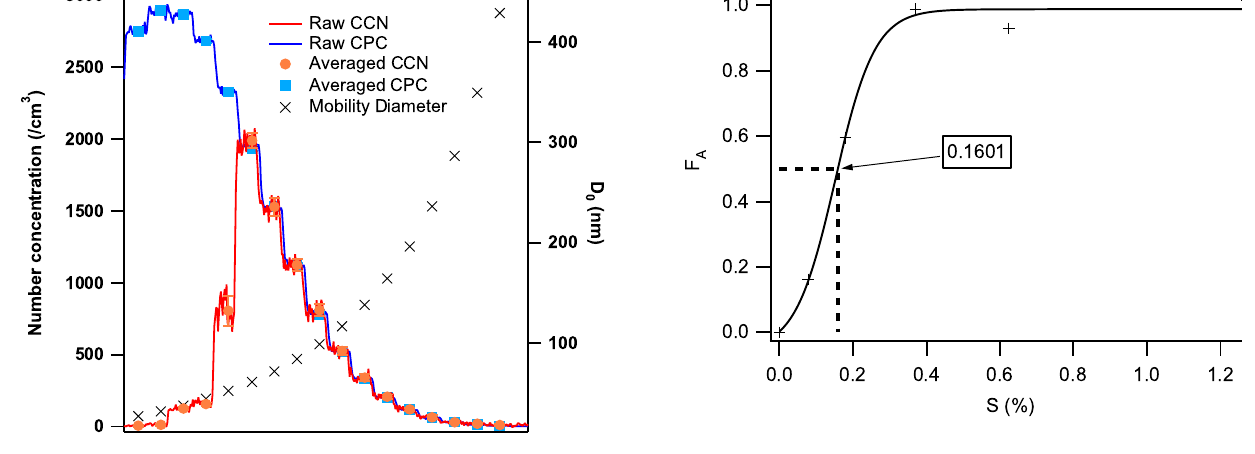
Fig. 7. Example plot of F A vs. S , with a sigmoid fit used to deter- mine S c measured during the MAP